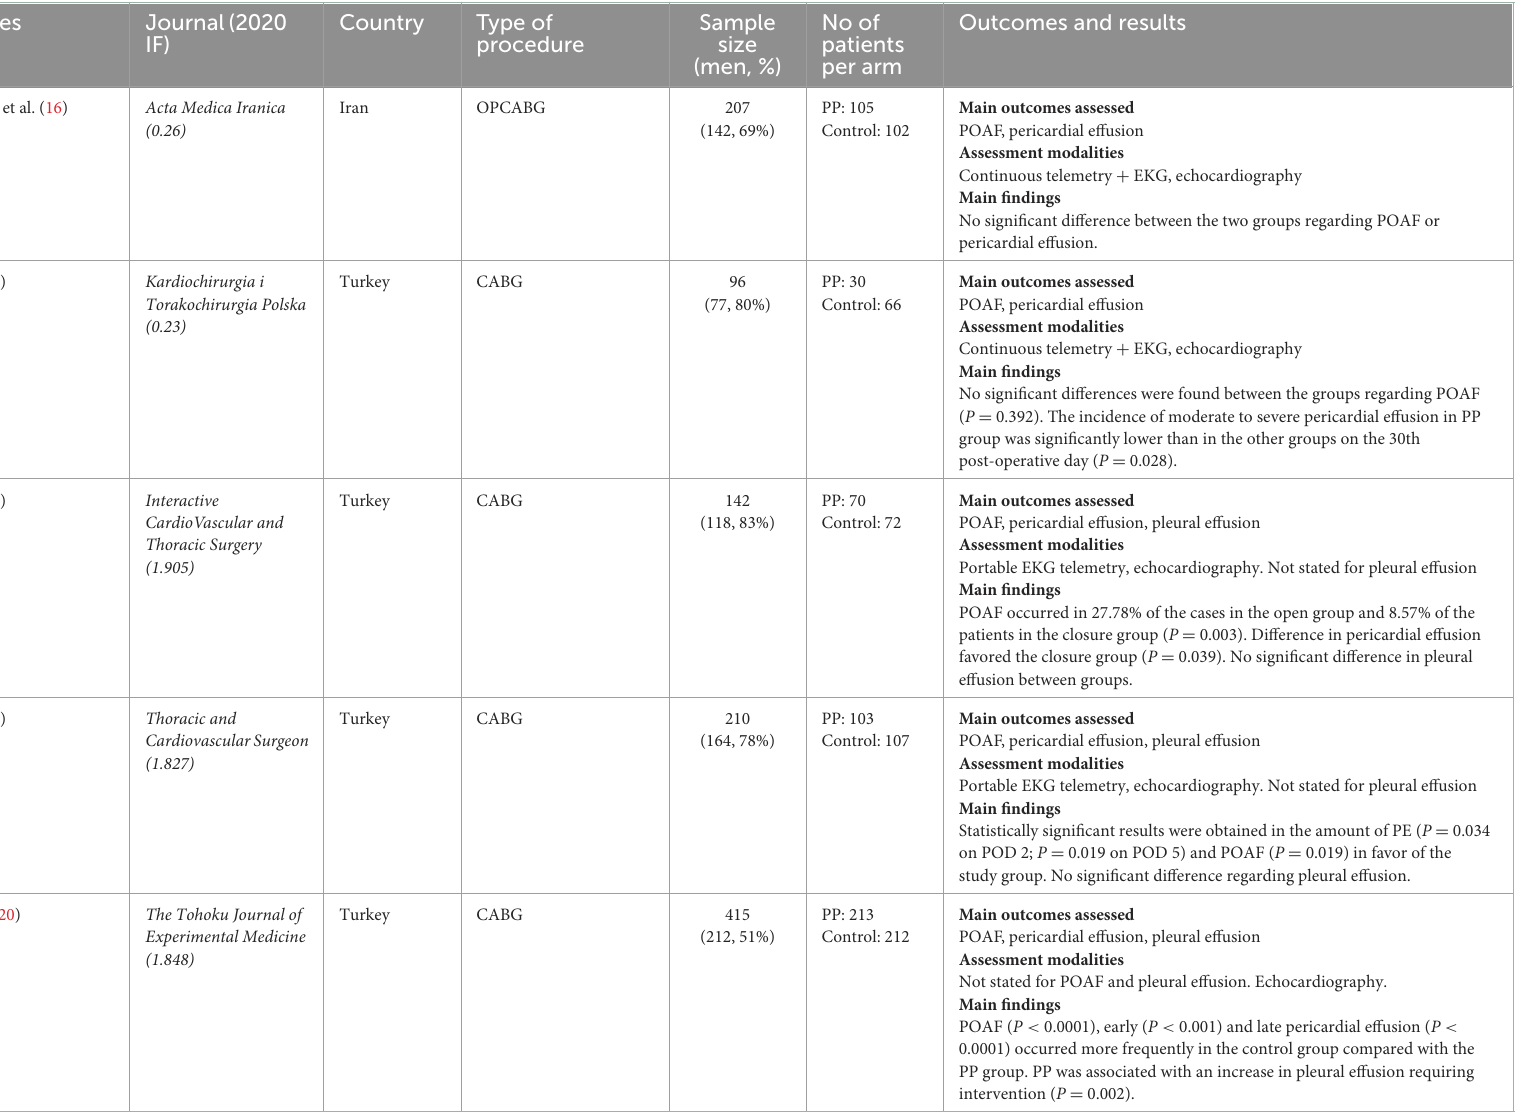
Main outcomes assessed POAF, pericardial effusion Assessmentmodalities Continuous telemetry + EKG, echocardiography Main findings No significant difference between the two groups regarding POAF or pericardial effusion. Main outcomes assessed POAF, pericardial effusion Assessmentmodalities Continuous telemetry + EKG, echocardiography Main findings No significant differences were found between the groups regarding POAF ( P = 0.392). The incidence of moderate to severe pericardial effusion in PP group was significantly lower than in the other groups on the 30th post-operative day ( P = 0.028). Main outcomes assessed POAF, pericardial effusion, pleural effusion Assessmentmodalities Portable EKG telemetry, echocardiography. Not stated for pleural effusion Main findings POAF occurred in 27.78% of the cases in the open group and 8.57% of the patients in the closure group ( P = 0.003). Difference in pericardial effusion favored the closure group ( P = 0.039). No significant difference in pleural effusion between groups. Main outcomes assessed POAF, pericardial effusion, pleural effusion Assessmentmodalities Portable EKG telemetry, echocardiography. Not stated for pleural effusion Main findings Statistically significant results were obtained in the amount of PE ( P = 0.034 on POD 2; P = 0.019 on POD 5) and POAF ( P = 0.019) in favor of the study group. No significant difference regarding pleural effusion. Main outcomes assessed POAF, pericardial effusion, pleural effusion Assessmentmodalities Not stated for POAF and pleural effusion. Echocardiography. Main findings POAF ( P < 0.0001), early ( P < 0.001) and late pericardial effusion ( P < 0.0001) occurred more frequently in the control group compared with the PP group. PP was associated with an increase in pleural effusion requiring intervention ( P =